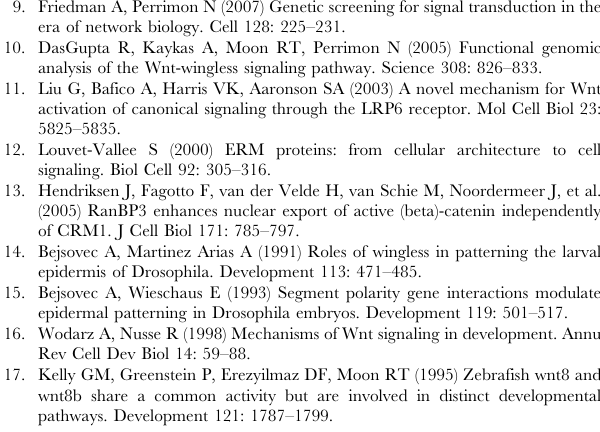
Figure S5 Bili negatively regulates Wnt/{capital b -catenin signaling in mammalian cells. (A) siRNA mediated knockdown of hBili enhances Wnt1 mediated induction of a b -catenin responsive reporter. HEK293T cells were transfected with siRNA targeting control, b -catenin, or hBili. Cells were then transfected with